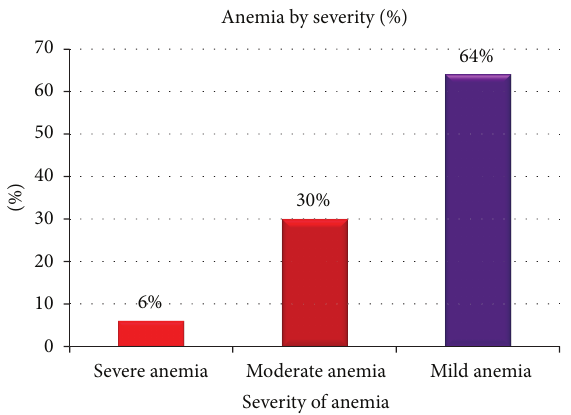
Figure 1: Percentage of anemia by severity among anemic pregnant women ( 𝑛 = 50